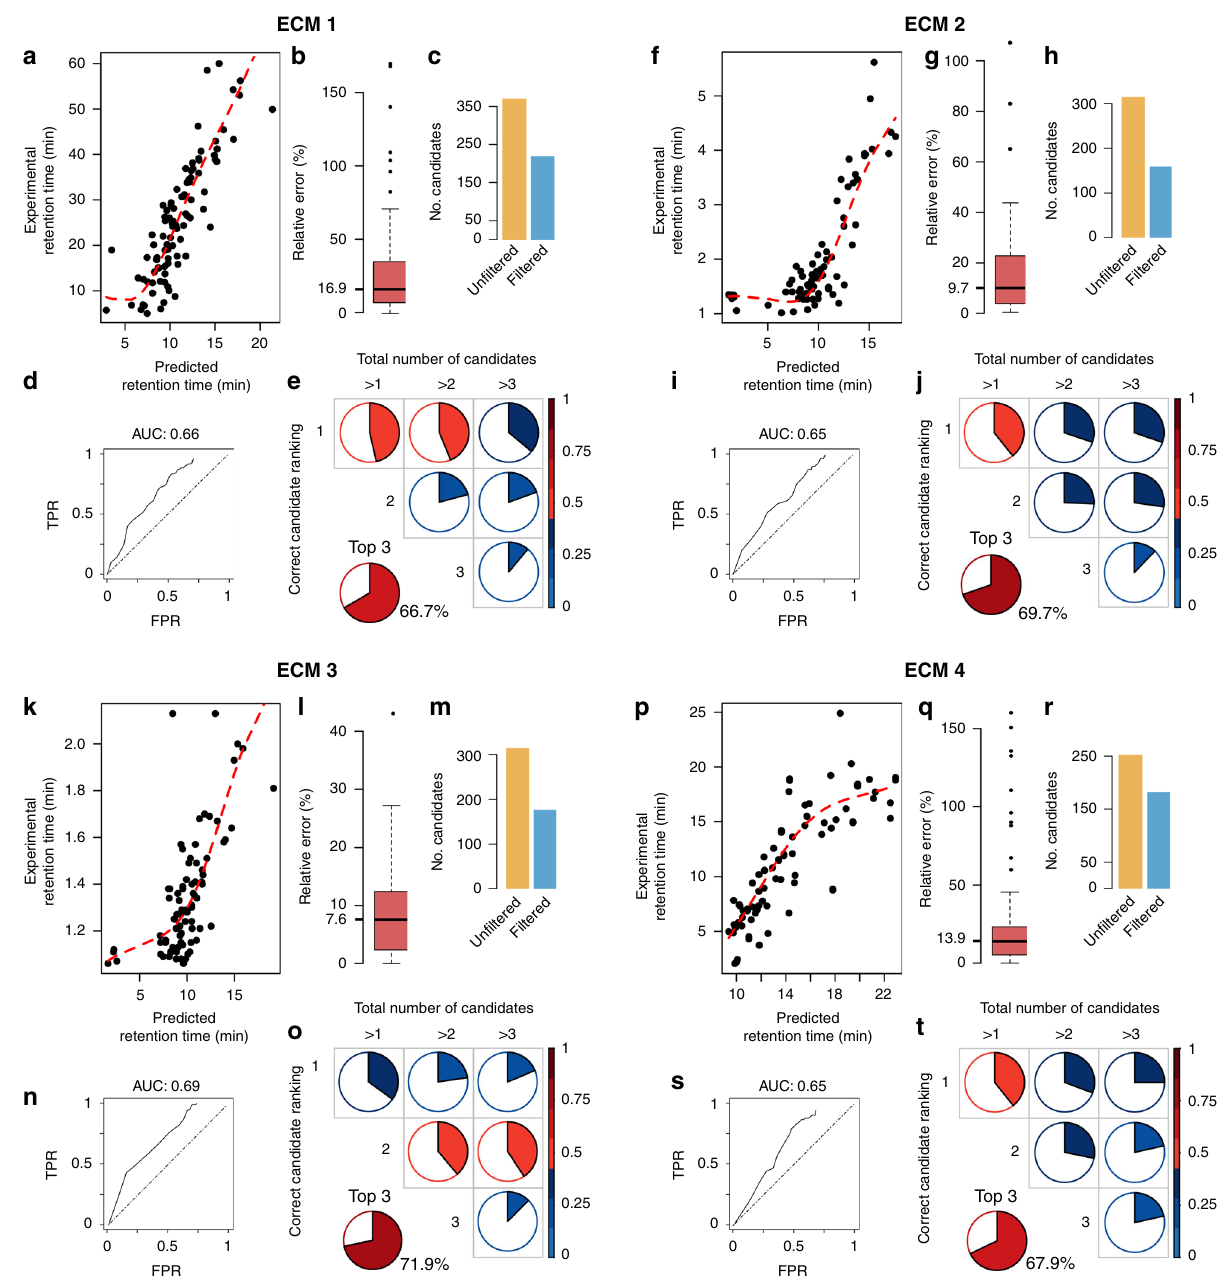
Fig. 5 Predicted – experimental projections results. Four experimental chromatographic methods (ECM 1 to 4) with fi ve panels each. In the PredRet database, ECMs 1 – 4 are known as FEM_long, LIFE_old, RIKEN and FEM_orbitrap_plasma, respectively. Panels a , f , k , p show the projection between the experimental and predicted RT. Panels b , g , l , q show relative errors between the experimental and predicted RT. Box plots represent median value and their error bars represent the interquartile range (25 – 75 % percentiles). Panels c , h , m , r show the number of putative candidates before and after fi ltering by RT error threshold. Panels d , i , n , s show the ROC curves with their respective AUC values. Panels e , j , o , t show the candidate ranking. Ranking panels show the percentage of molecules in which the correct identity is exactly the fi rst, second or third top candidate (y-axis, correct candidate ranking) and there are more than 1, 2 or 3 putative candidates in total (x-axis, total number of candidates). The top-three chart shows the percentage of cases in which the correct identity was ranked among the top three candidates of the total of cases with more than three